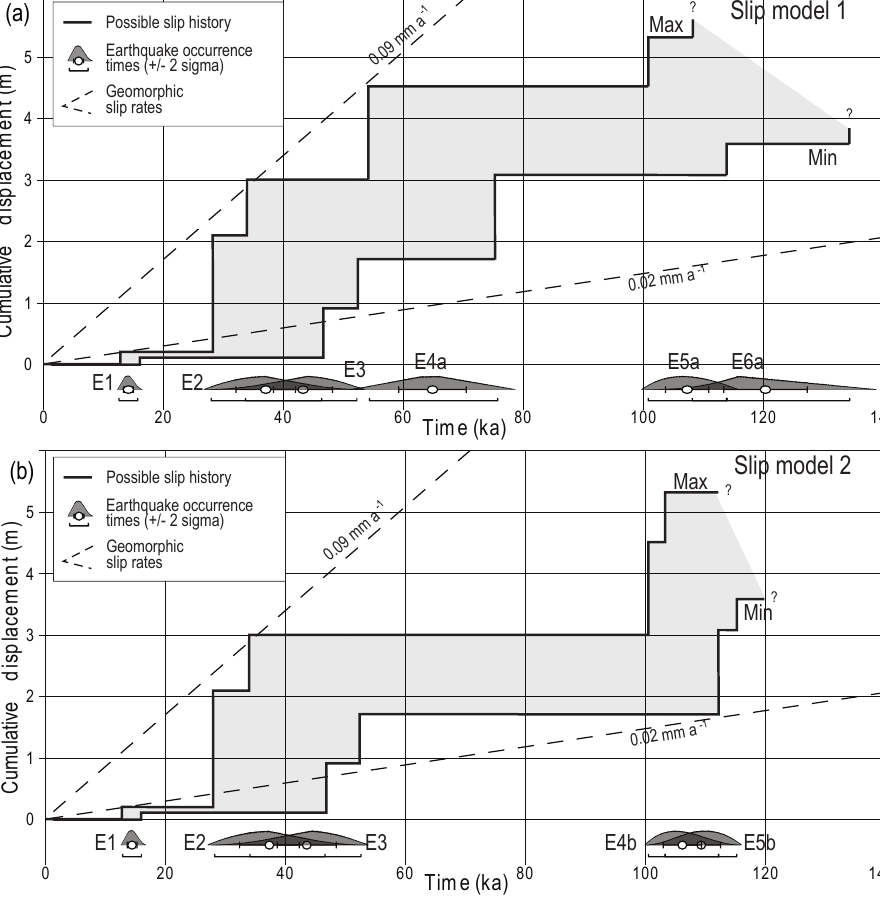
would be between 0.02 and 0.05 mm a − 1 for the time since E2 (37 ± 5 ka) using either 0.9 m (E1 + periglacial wedge) or 1.7 m (E1 + colluvial